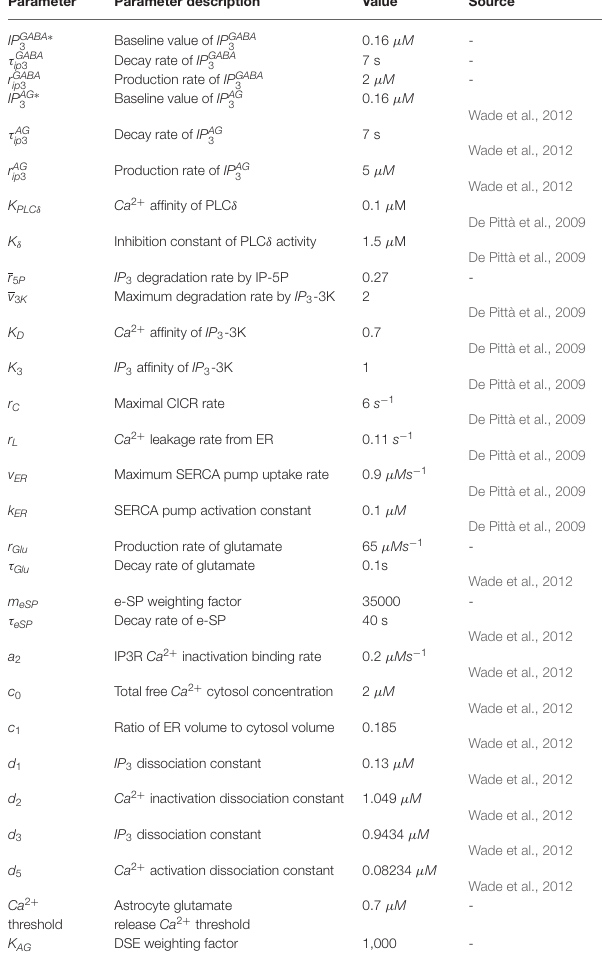
TABLE A2 | Astrocyte cell parameters.